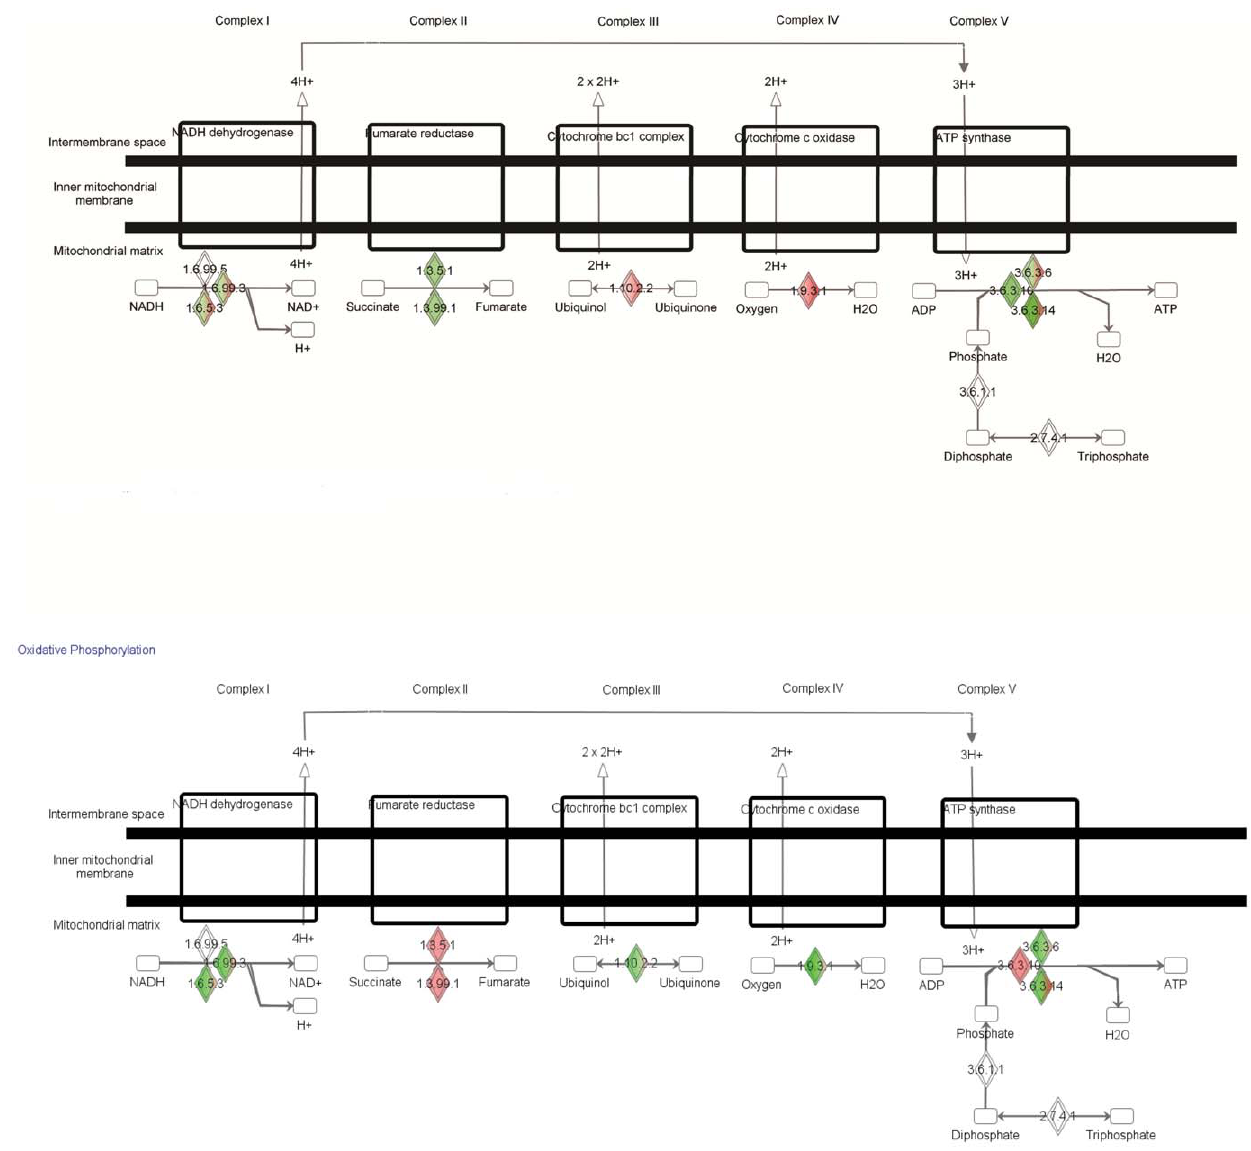
Figure 6. IPA analysis reveals oxidative phosphorylation pathway. Shown are the results from the IPA functional annotation after analysis of all the genes with a fold change value of equal or greater than 1.6 and P value of , 0.05. Up-regulated genes are colored in red, down-regulated genes in green. The diamond shapes with both colors contain gene families in which some genes are up-regulated, and some are down-regulated. Overall, the oxidative phosphorylation pathway was the most significantly activated pathway in the brain of HF Acads 2 / 2 (ratio 0.414) vs. HF Acads + / + , and of HF Acads + / + vs. LF Acads + / + (ratio 0.393) mice. Notably in HF Acads 2 / 2 vs. HF Acads + / + mice, we found significantly decreased expression of ATP synthase genes in mitochondrial complex 5 (top panel), consistent with a state of decreased energy